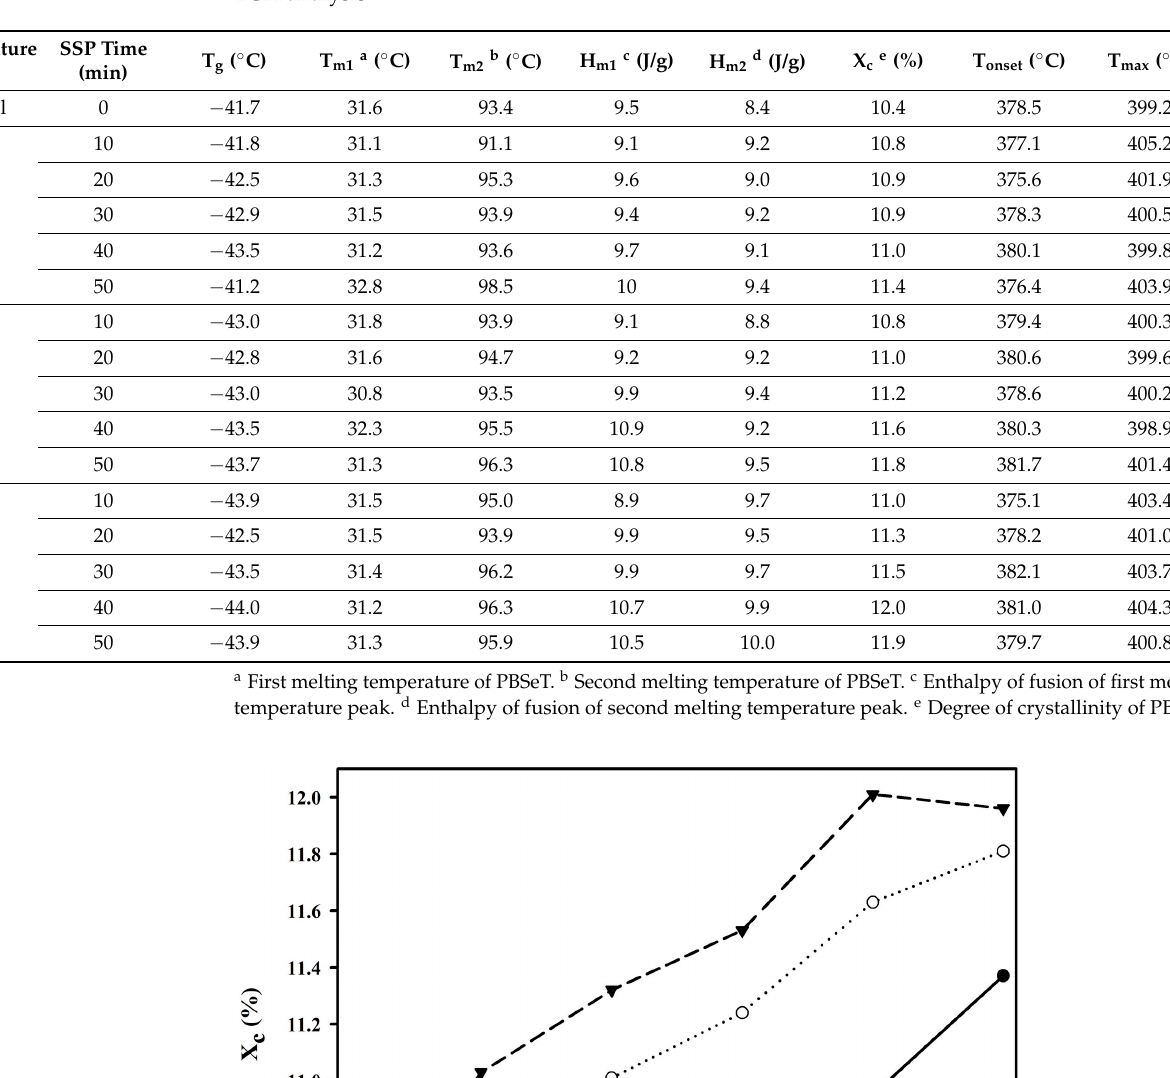
Table 1. Table 1. Thermal properties of PBSeT after SSP at different temperatures, obtained from DSC and TGA analysis.